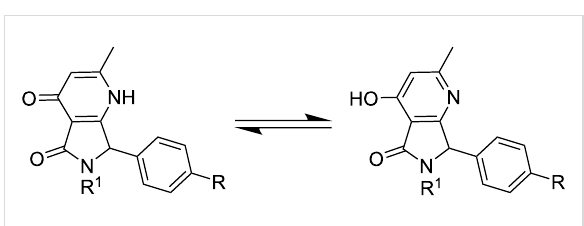
Scheme 5: Tautomeric equilibrium of pyrrolo[3,4- b ]pyridin-5-one deriv- atives 1 in solution.